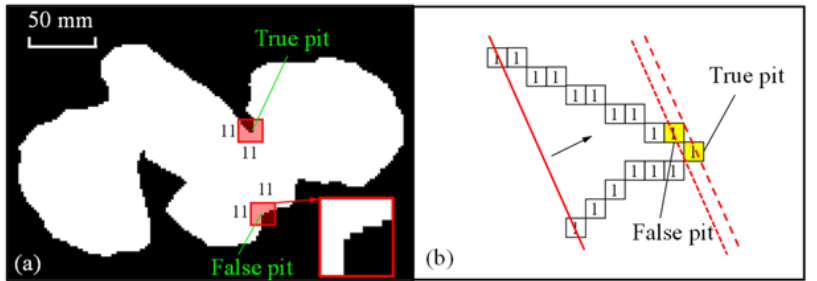
Figure 10. Analysis of the reasons for the existence of false pits: ( a ) Extract that number of pixel in an area of 11 × 11 centered on a pit, ( b ) False pits on both sides near the true pits.